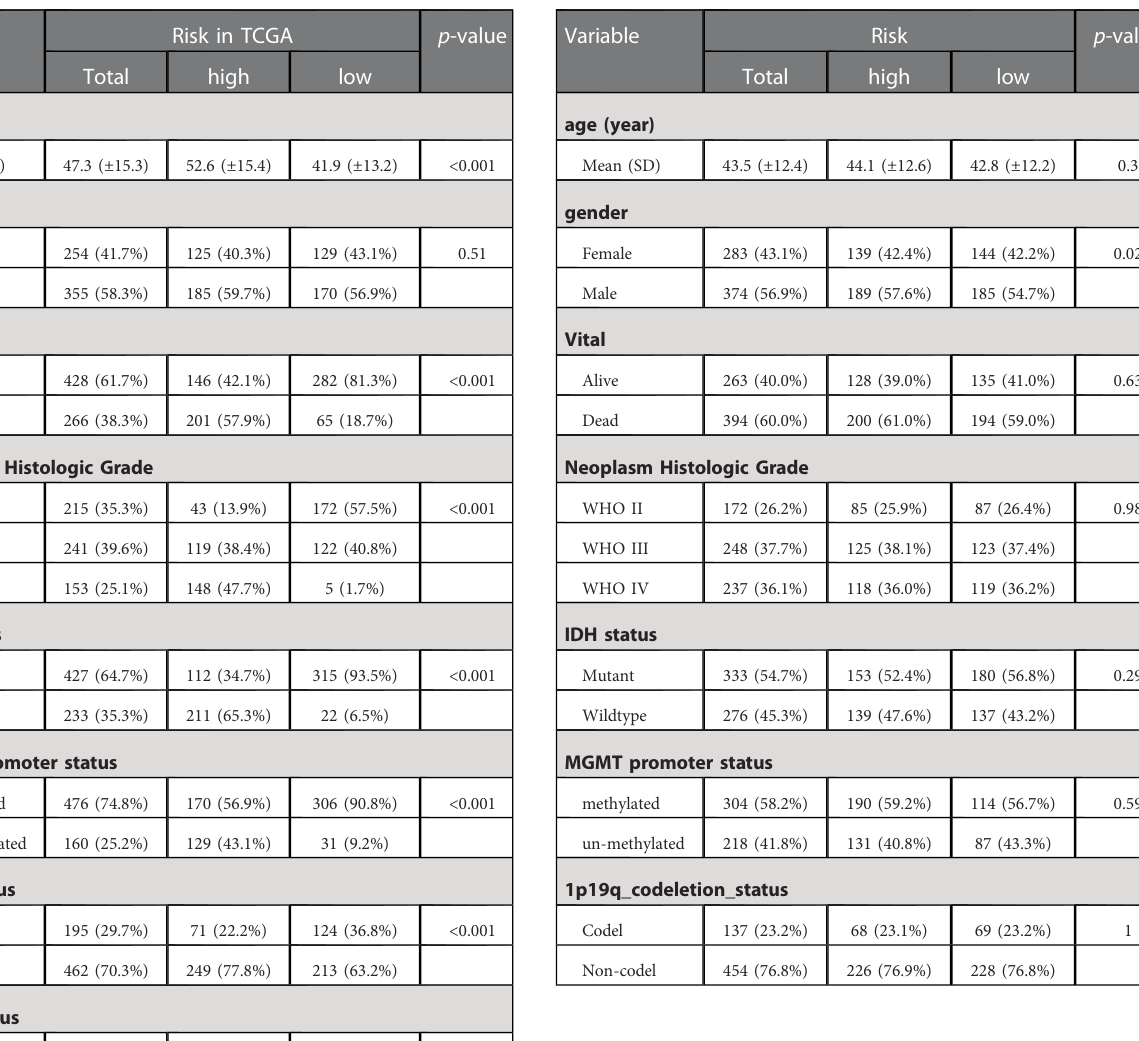
TABLE 3 Risk and clinical data in TCGA. TABLE 4 Risk and clinical data in